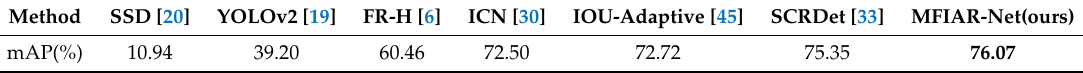
Table 7. Comparison of detection accuracy of different methods with HBB on